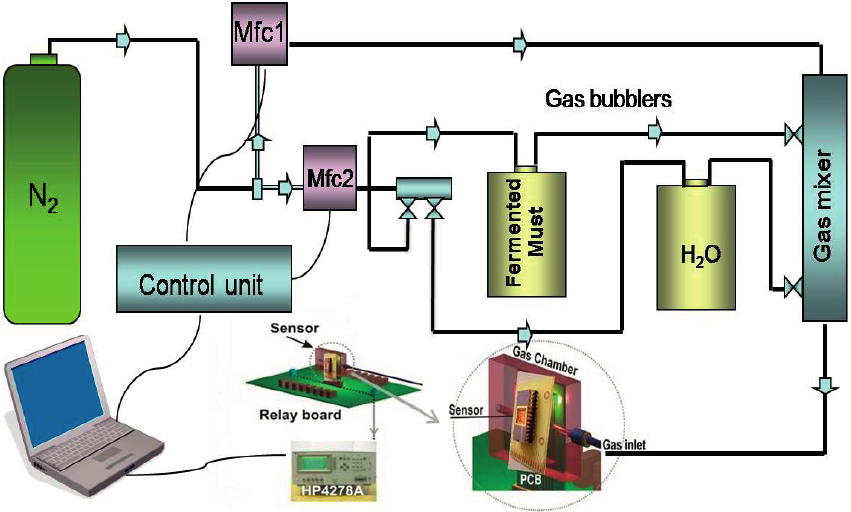
Figure 1. Experimental set up for the interface of the volatile headspace of the examined fermented medium with the sensor